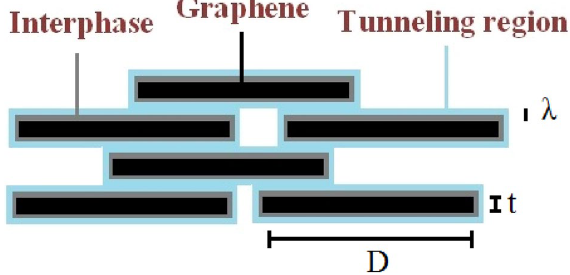
Figure 2. Graphene nanosheets, tunneling and interphase pieces in